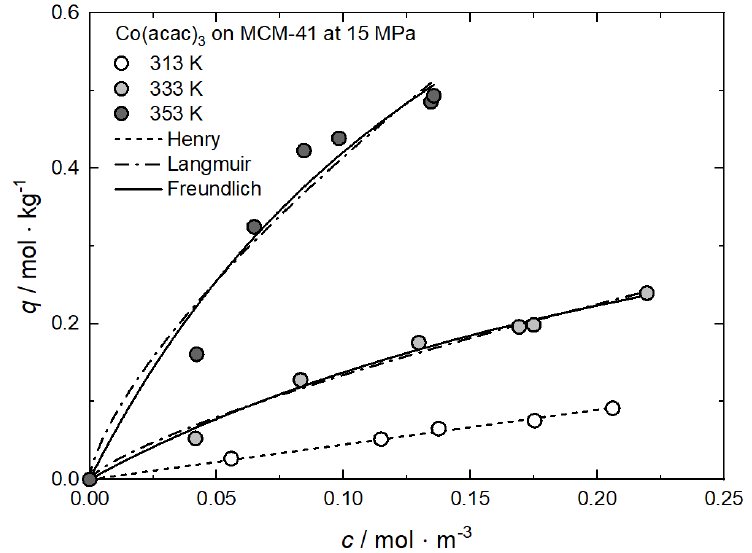
Figure 9. Uptake of Co(acac) 3 on MCM-41 at 15 MPa and different temperatures; experimental data taken from [60].